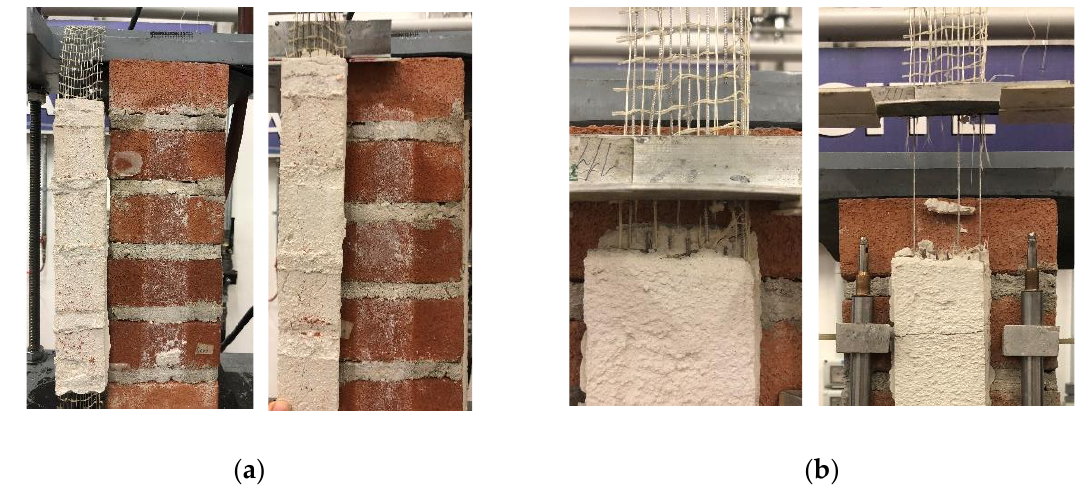
Figure 12. Failure modes of SRG-masonry joints: ( a ) D ms (specimen DS_300_50_S_W/D_3) and ( b ) MD mf R (specimen DS_300_50_S_W/D_6).